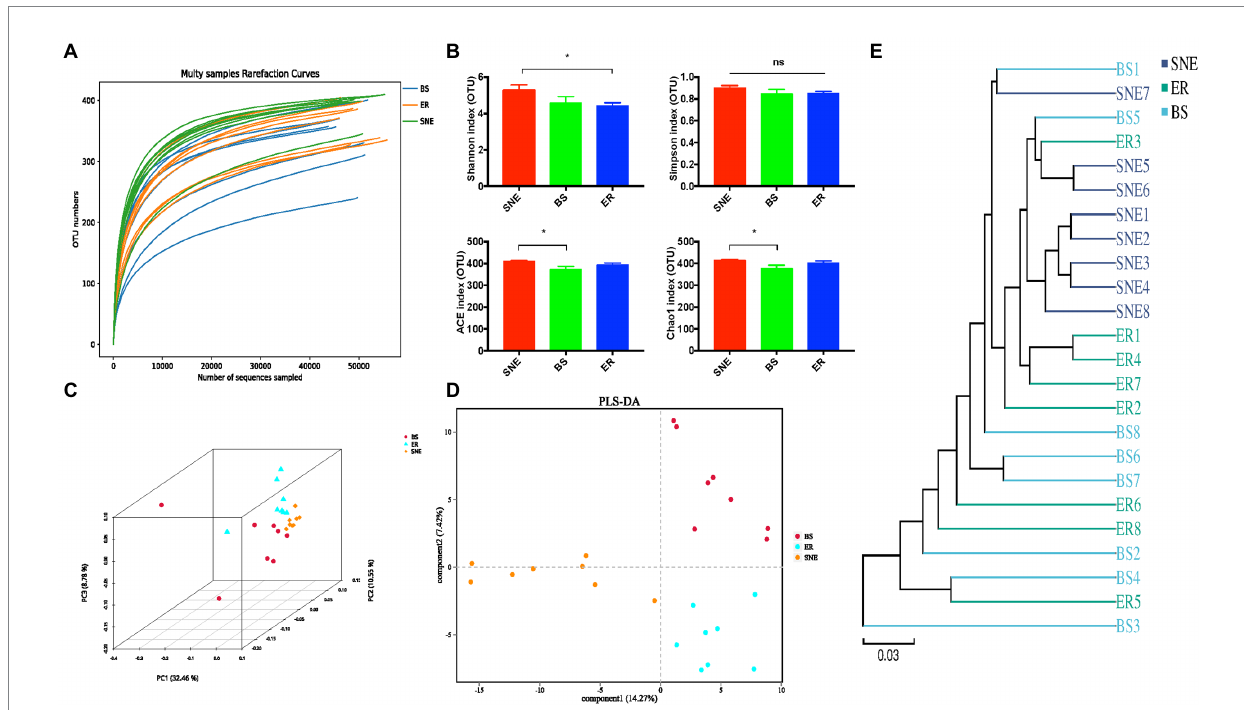
FIGURE 6 The cecal bacterial community of broilers among SNE, BS and ER treatments. (A) Rarefaction curve for total OTUs. (B) α -Diversity of gut microbiota was analyzed among SNE, BS and ER treatment groups by determination of principal dimension Simpson indices. (C) Three dimensional figures at the operational taxonomic unit (OTU) level obtained from PCoA based on the Bray–Curtis phylogenetic distance metric. (D) Partial least squares discriminant analysis of gut microbiota at the OTU level. (E) Unweighted pair-group method with arithmetic means (UPGMA) analysis based on the unweighted UniFrac. SEM, standard error of mean. Each value represents the mean ± SEM of 8 replicates ( n = 8). The abbreviation of Ctr, SNE, BS and ER have the same meaning as Table 3.